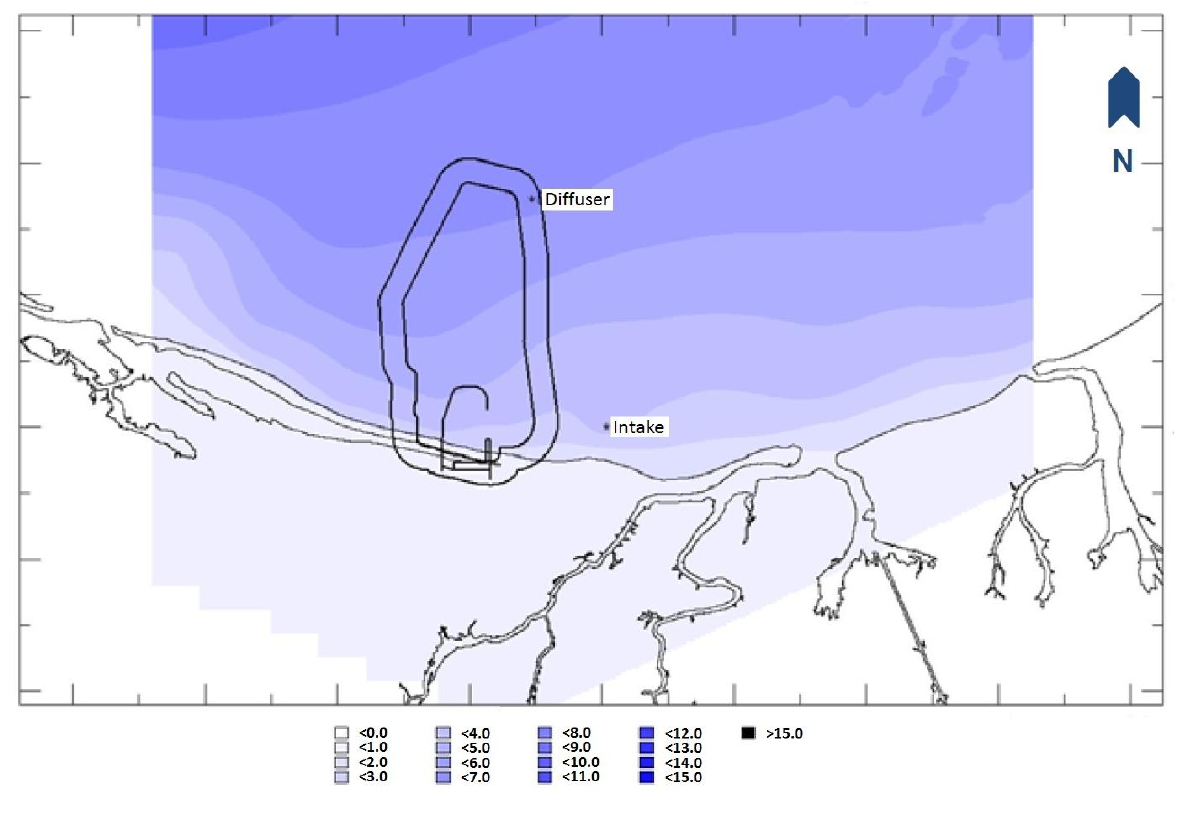
Figure 3. Bathymetry near the outfall location (depths are in meter relative to